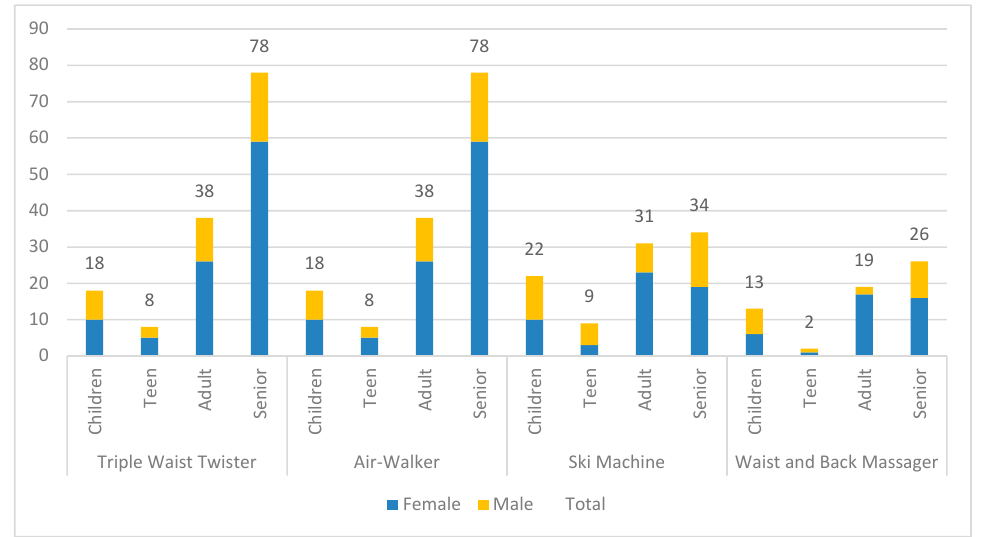
Figure 1. Observed outdoor fitness equipment (OFE) user counts in terms of age and gender for each piece of equipment.